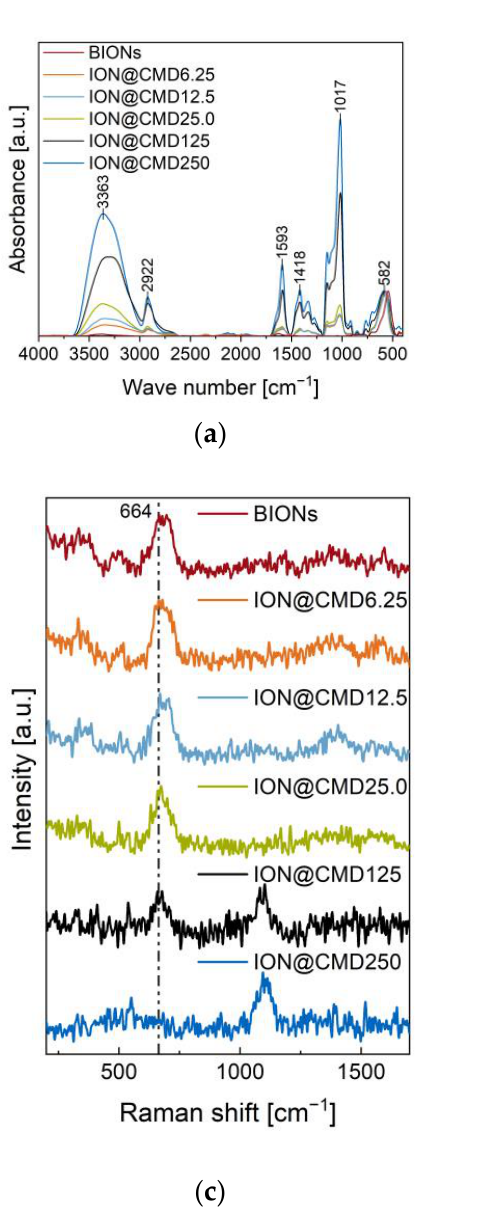
Figure 2. FT-IR Spectra of synthesized IONs@CMD and BIONs at wavenumbers between 4000 and 450 cm −1 ( a ). All spectra were normalized on the magnetite band around 582 cm −1 . Raman spectra of ION@CMDs and BIONs ( b ). The fit of the A 1g band is between 600 and 750 cm −1 using Voigt functions in Origin ( c ). X-ray diffractogram of ION@CMD12.5 ( d ).